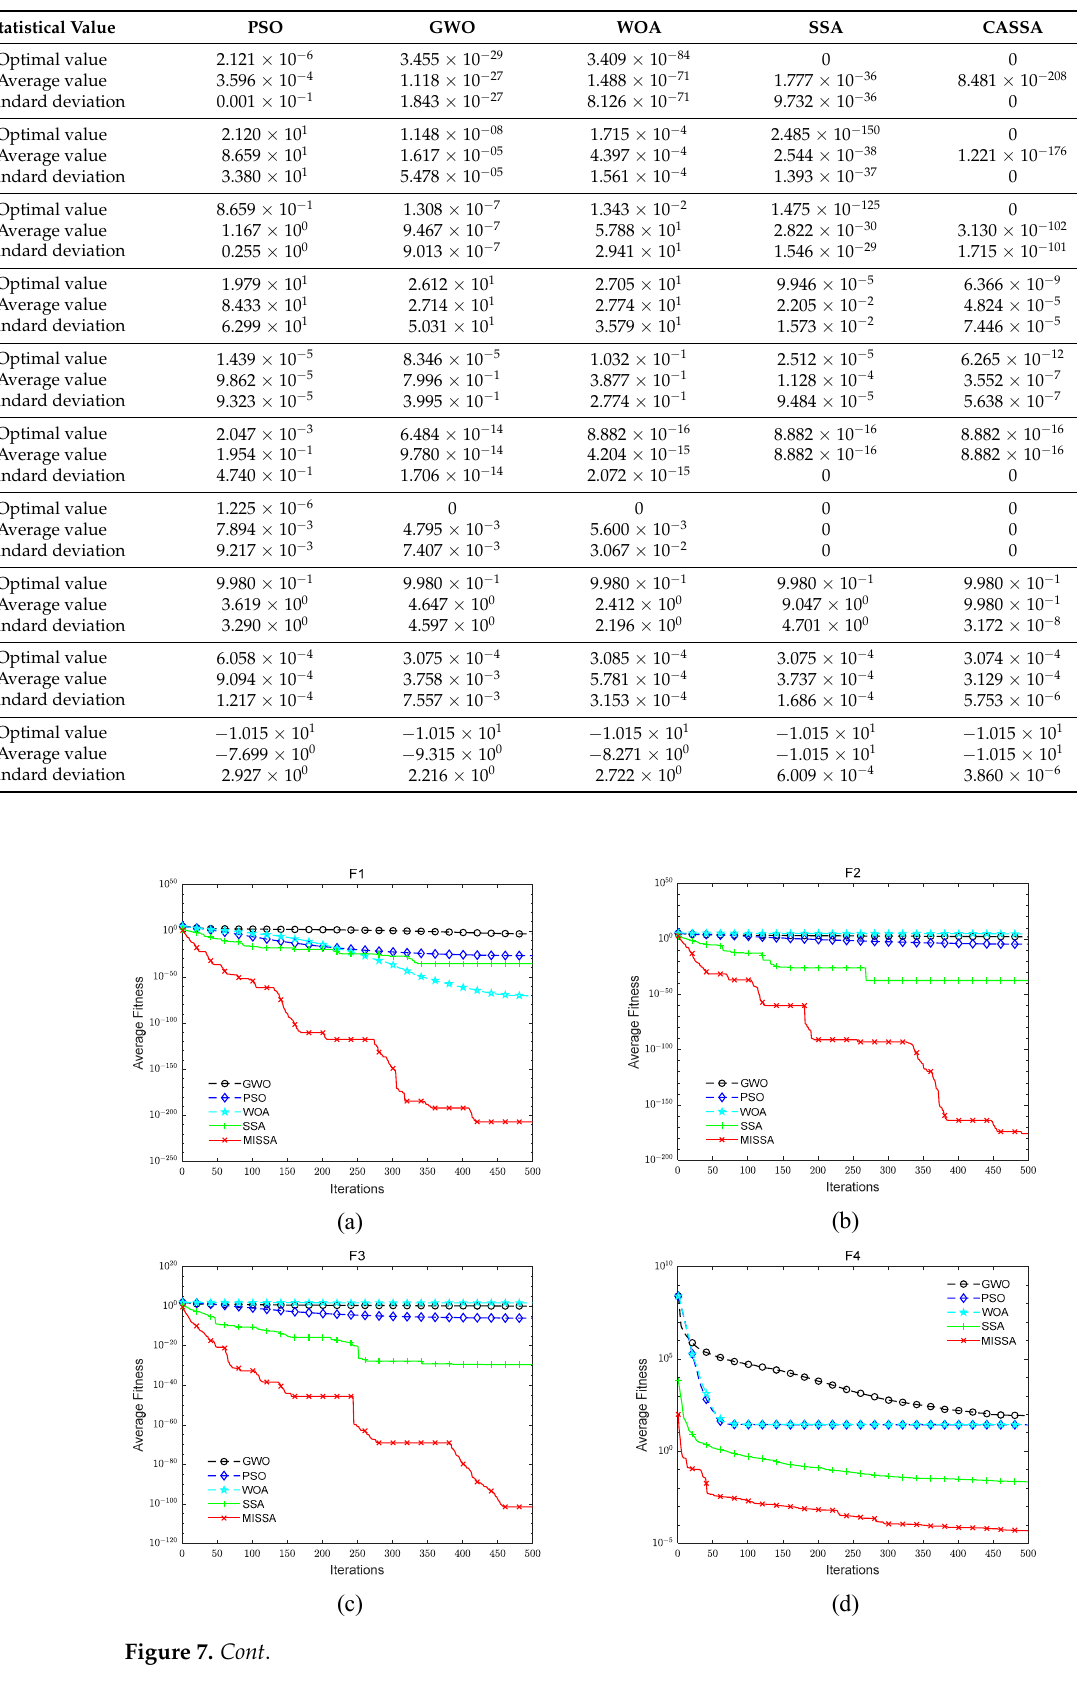
Table 2. Benchmark function test results.